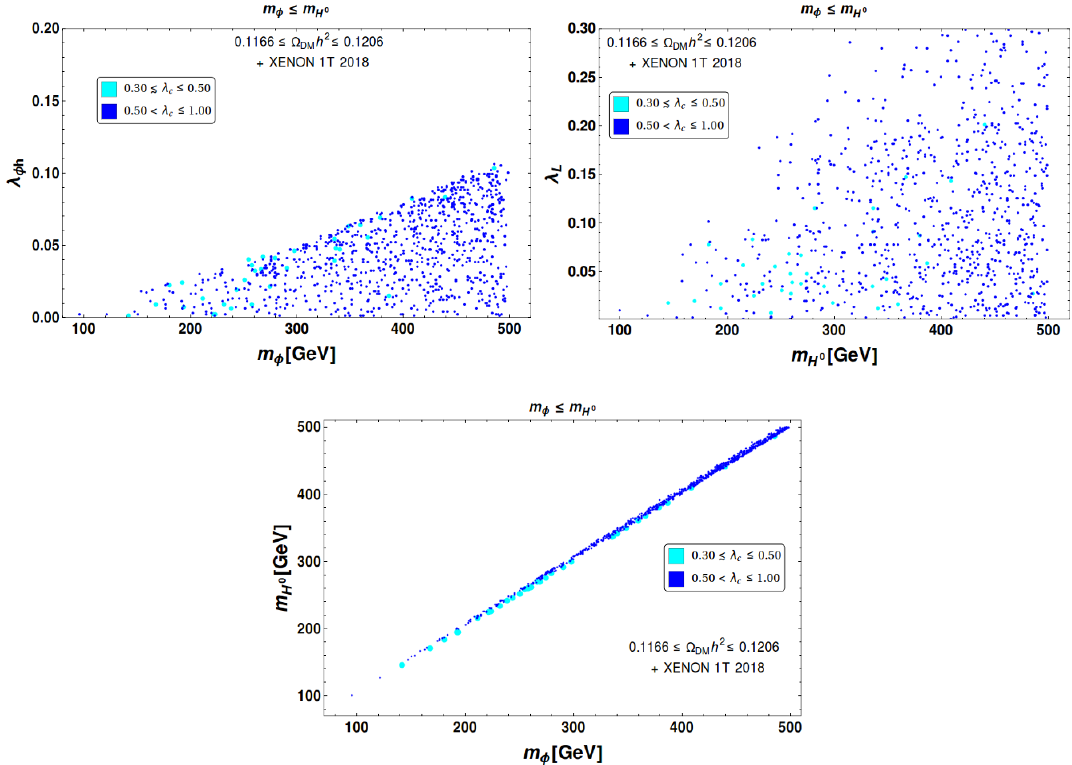
Figure 16 . Relic Density and direct detection (XENON 1T 2018) at NLO allowed parameter space is shown in: m (cid:30) (cid:0) (cid:21) (cid:30)h plane (top left panel), m plane (bottom panel). The scans are performed for the mass hierarchy m (cid:30) (cid:20) m